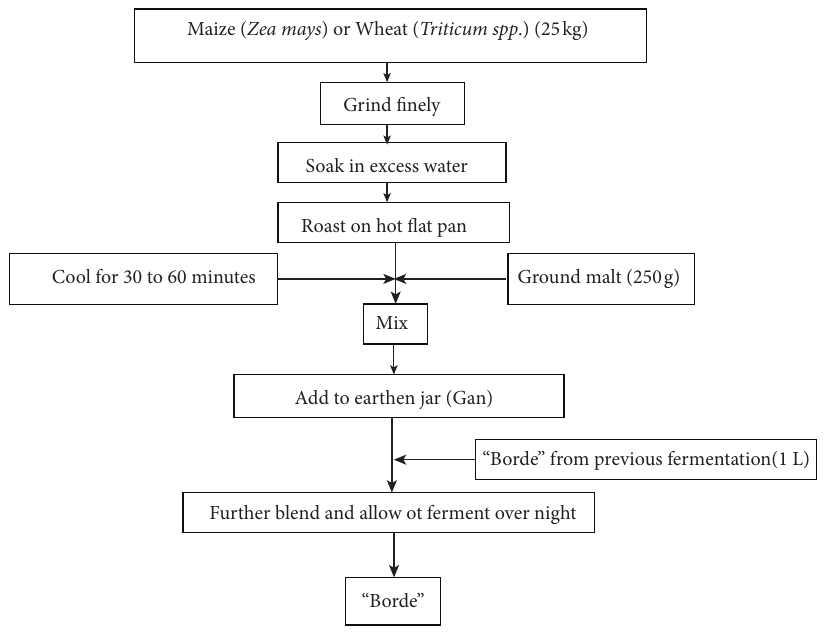
Figure 2: Flow chart of the Borde fermentation process [15].